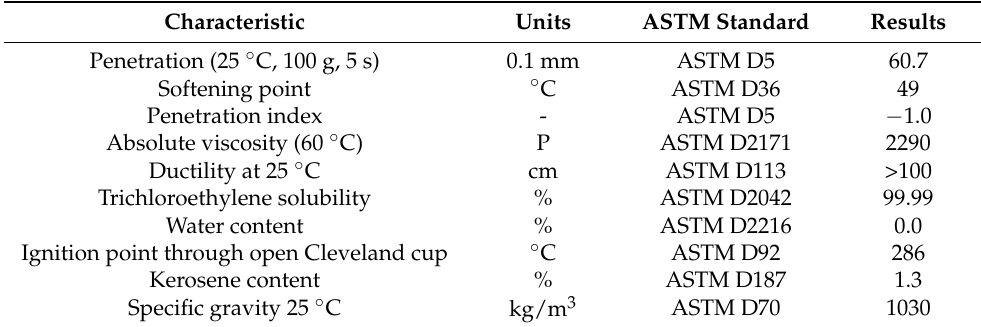
Table 1. Properties of the asphalt binder used in this